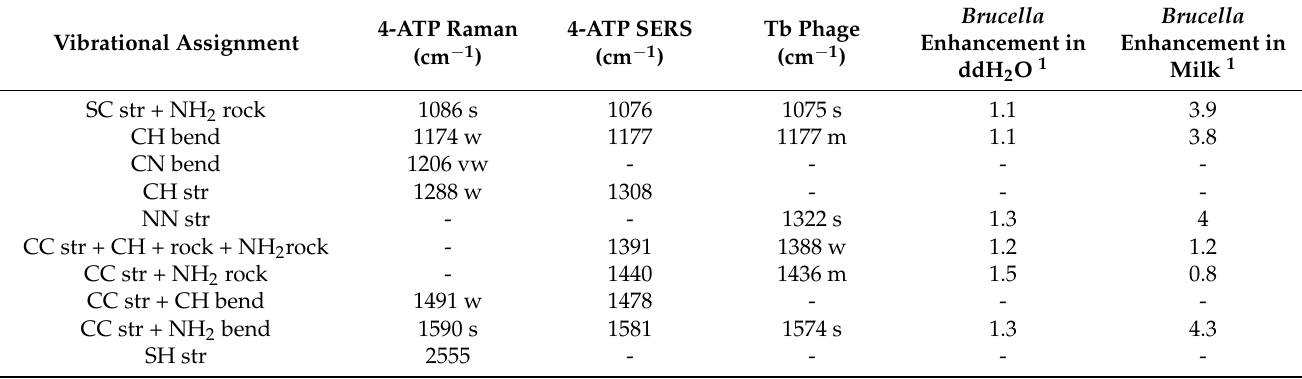
Table 1. Vibrational assignment of Raman and SERS spectra.